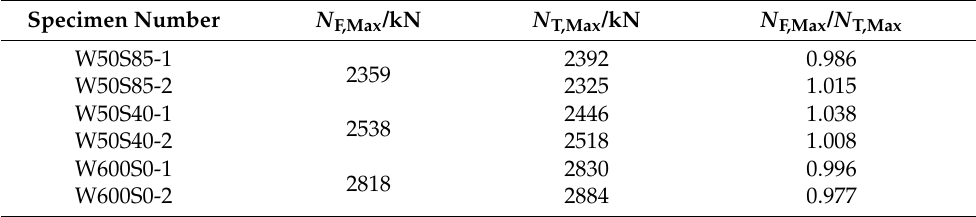
Figure 9. Comparison of the experimental failure results with the finite element simulation results: ( a ) W50S85; ( b ) W50S40; and ( c ) W600S0. Table 7. Comparison of the finite element simulation results and the experimental load capacity values.